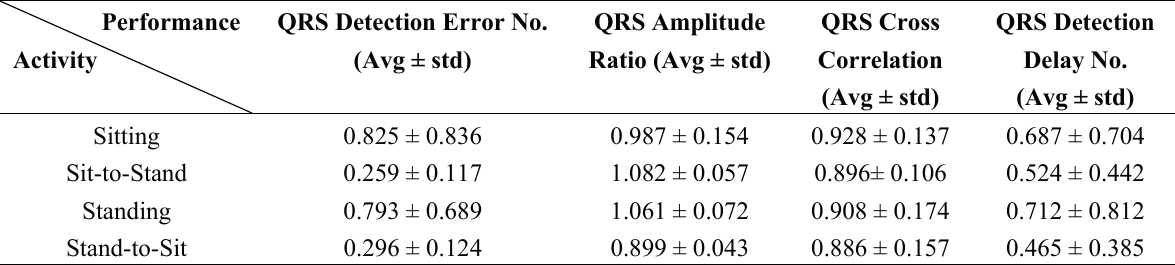
Table 7. Performance comparison between the proposed sensor and BIOPAC in real-life